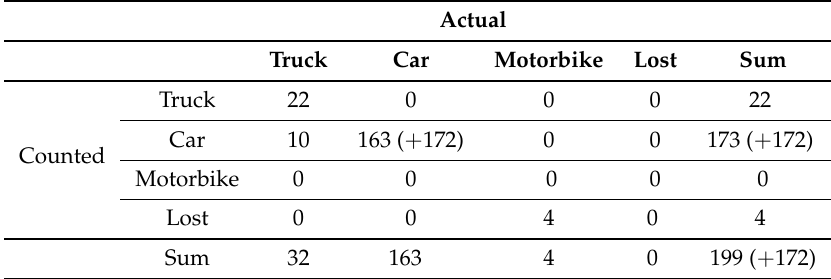
Table 8. Counting results per vehicle type from a highway with 500 ms request interval. Nearly every vehicle is counted twice.